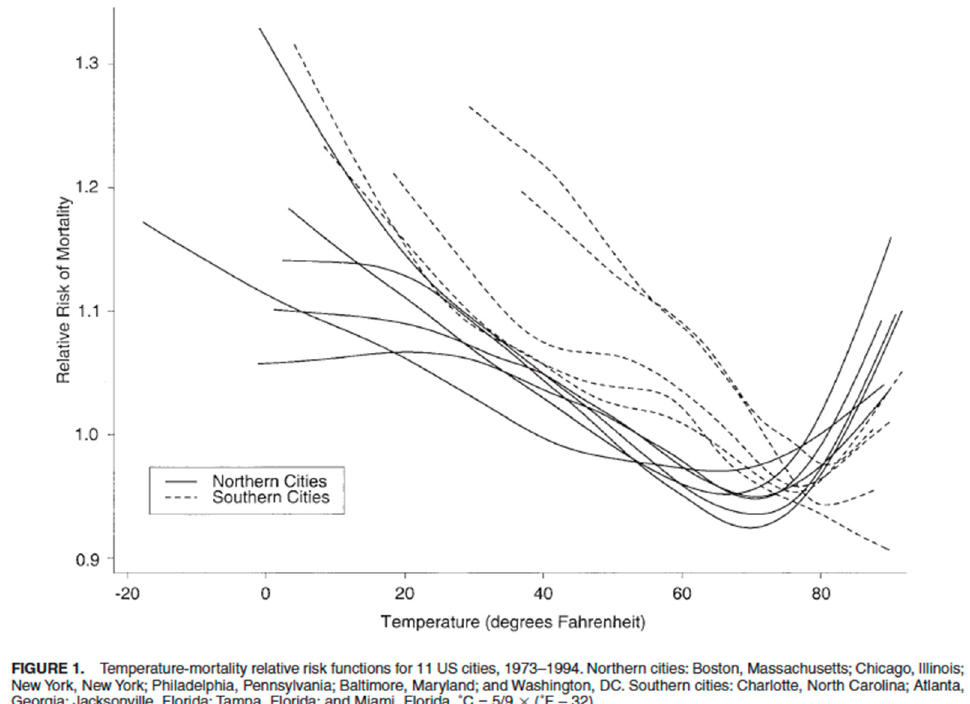
Figure 1. from Curriero et al., 2002 [7] showing temperature ‐ mortality risk functions for 11 US cities. Figure 1. From Curriero et al., 2002 [7] showing temperature-mortality risk functions for 11 US